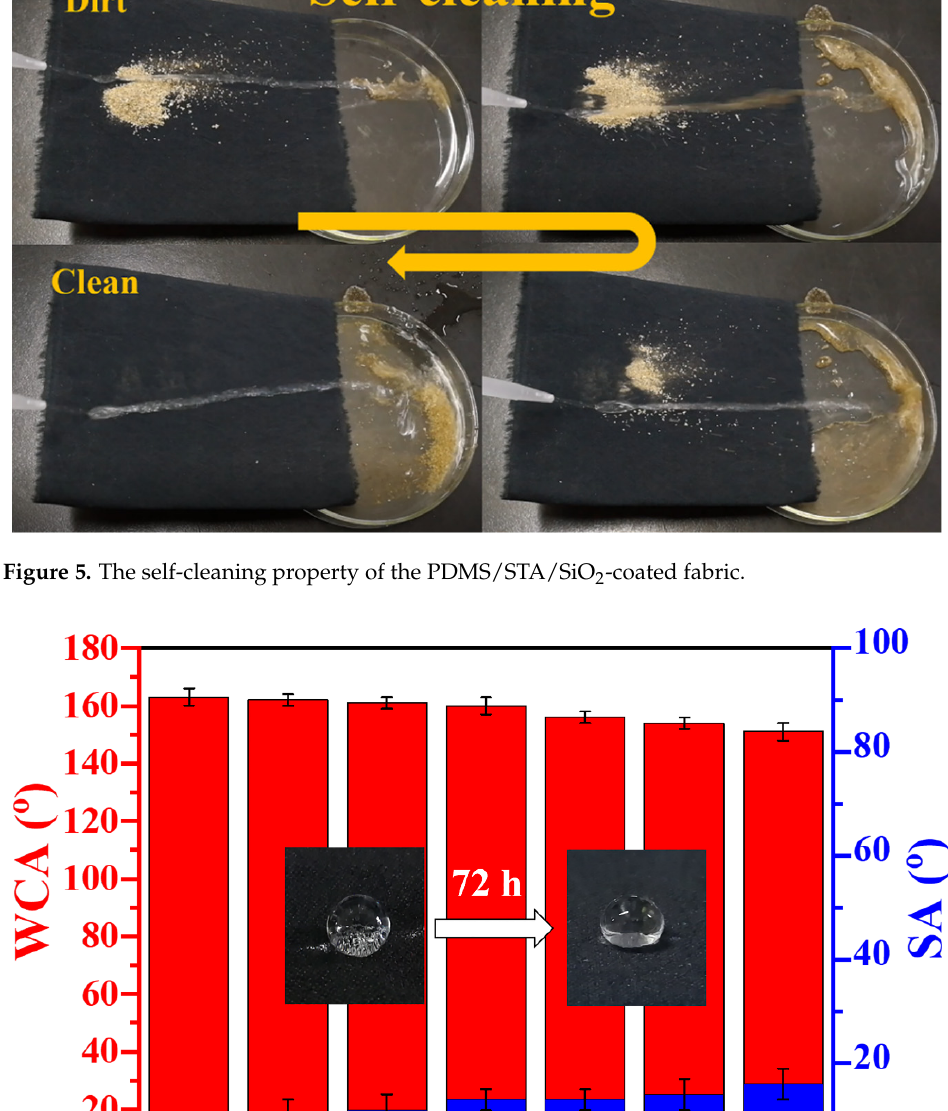
Figure 6. Changes in the WCAs and SAs of the PDMS/STA/SiO 2 -coated fabric with UV irradiation time. Insets are photographs of a water droplet on the PDMS/STA/SiO 2 -coated fabric before and after 72 h of UV irradiation.